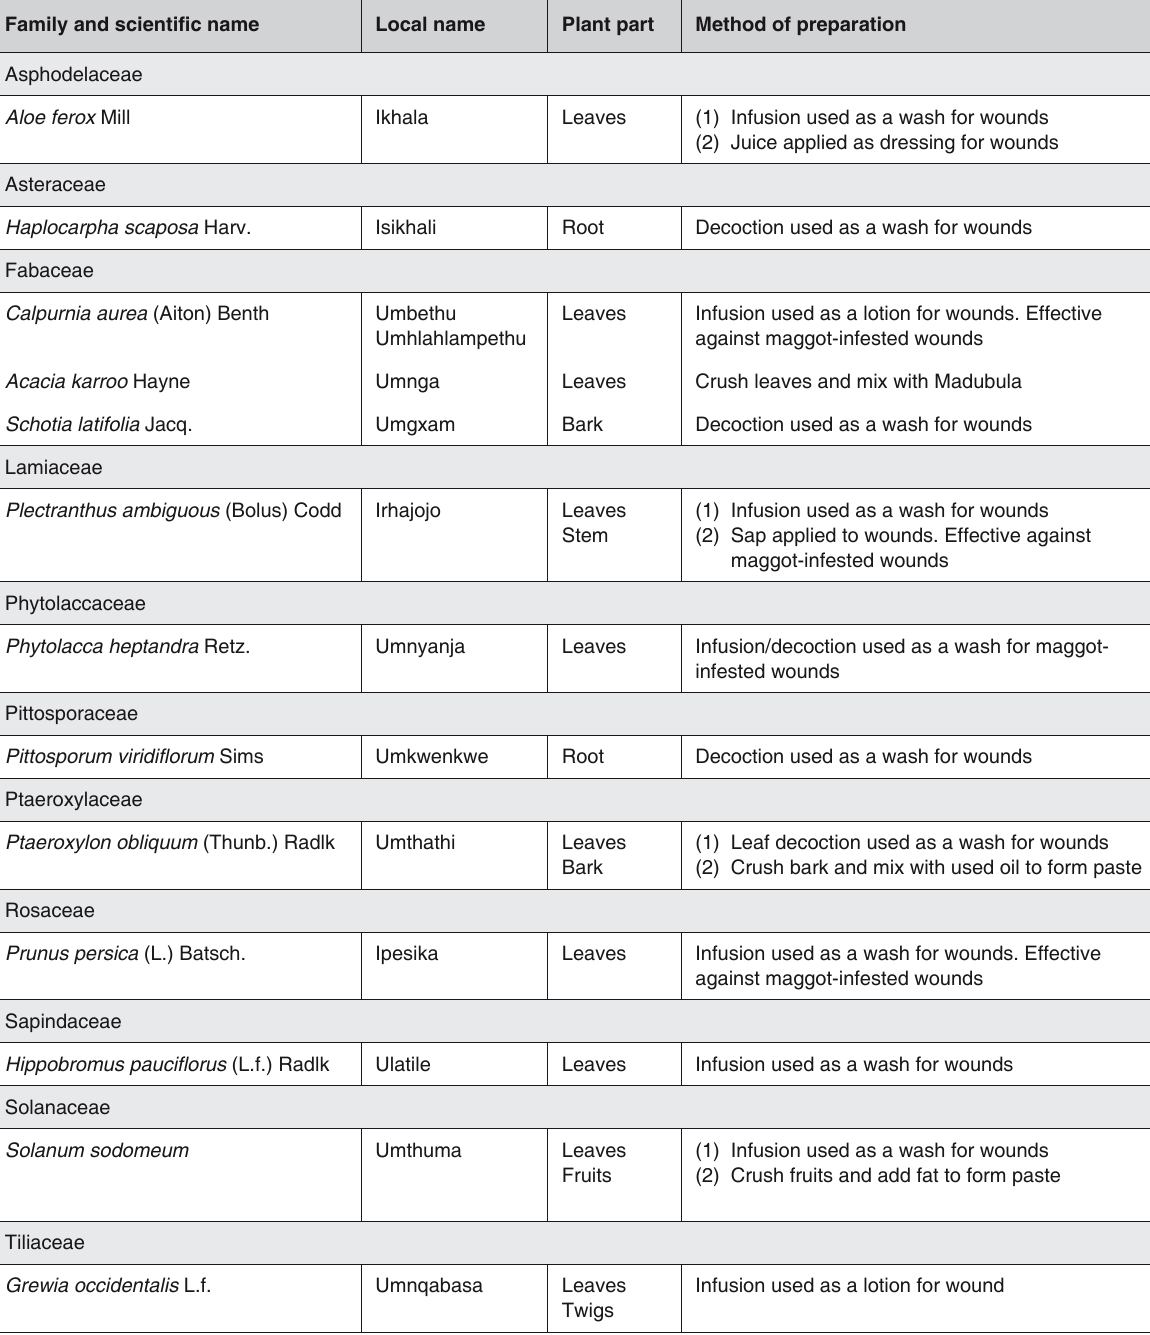
TABLE 1 List of plants used for the treatment cattle wounds and myiasis, plant part used and method of preparation reported by the respondents in Amatola Basin, Eastern